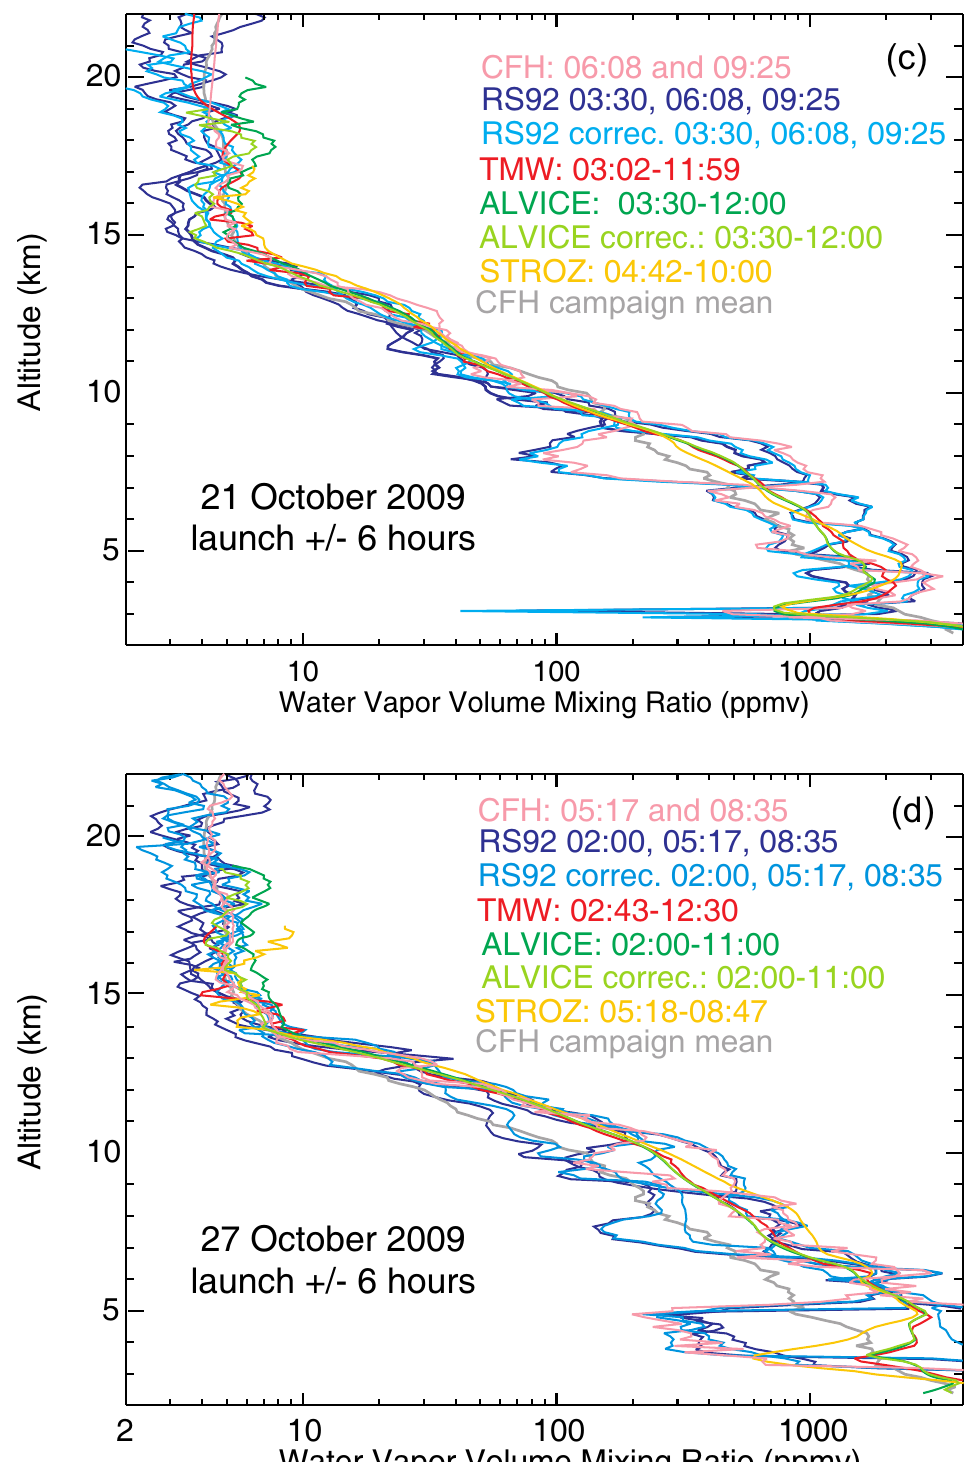
Fig. 5c and d. Balloon-borne and lidar water vapor profiles measured on various campaign nights (with various coincidence criteria apply- ing). Lidar integrated for several hours with a ± 6h coincidence criterion with balloon measurements. See text for